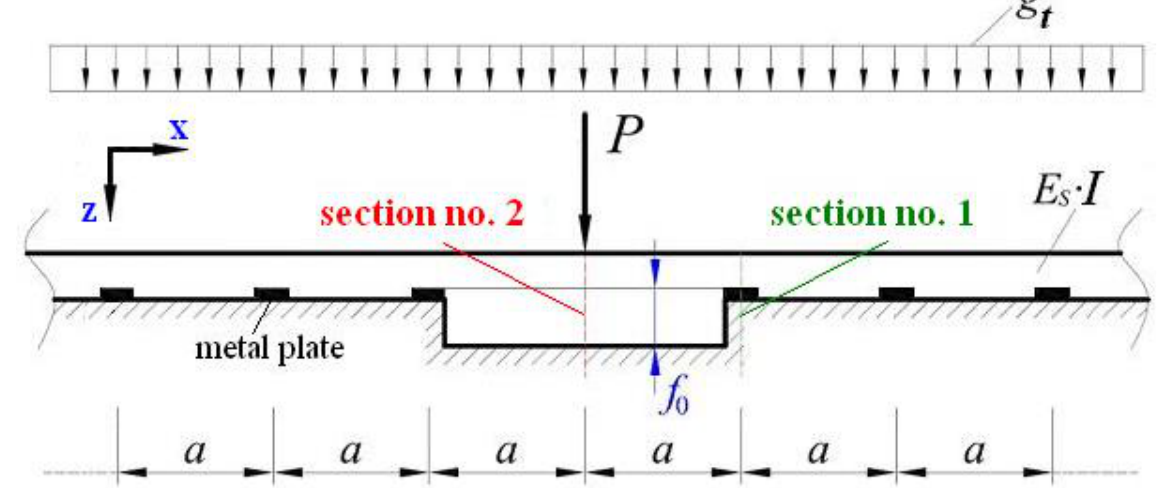
Figure 3. A scheme of induced irregularity in a railway track [author’s scheme].